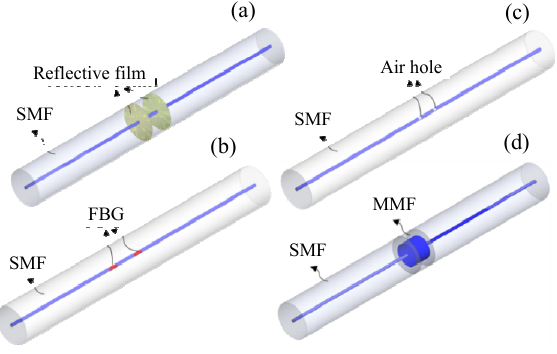
Fig. 12 Configurations of inline-type IFPI based on (a) reflective film, (b) FBG pair, (c) air hole, and (d)